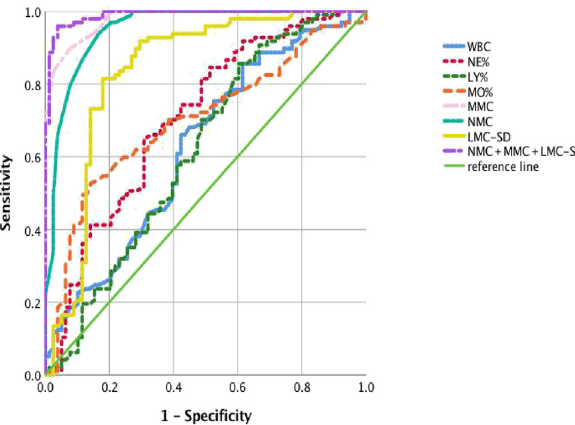
Figure 1: Analysis each parameter between ATB and CAP which under the ROC curve. Diagnostic value was appraised by the receiver operating characteristic ( ROC ) curve. Cuto ff value was de fi ned based on the max You - den ’ s index, which is the value when the di ff erence between the sensitivity and 1 - speci fi city of all points on the ROC curve is the largest. Compared with the WBC count and three of WBC conventional di ff erential count, the CPD parameter achieved a higher AUC, and the maximum area under the AUC curve obtained by combining MNC, MMV, and MMC was 0.99. WBC, white blood cells; NE%, neutrophil percentage; LY%, lymphocyte percen - tage; MO%, monocyte percentage; NMC, neutrophil mean conduc - tivity; MMV, monocyte mean volume; MMC, monocyte mean